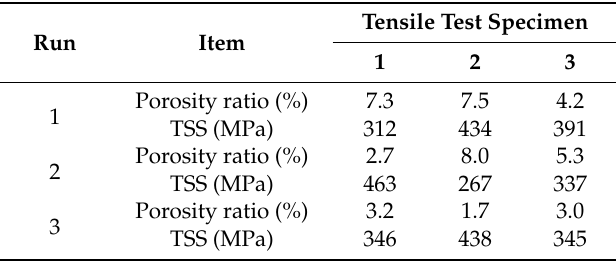
Table 5. Porosity and tensile shear strength (TSS) of each test specimens (gap: 0 mm).